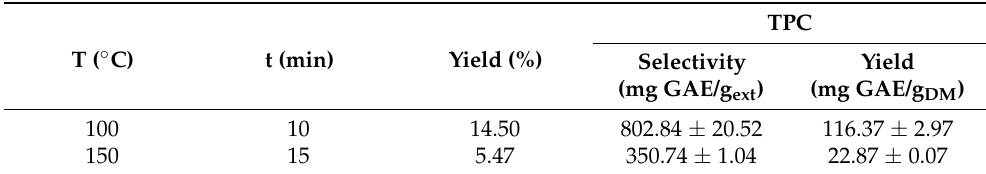
Table 5. Extraction conditions, yield, and TPC of the samples obtained with the process performed at 100 ◦ C and 150 ◦